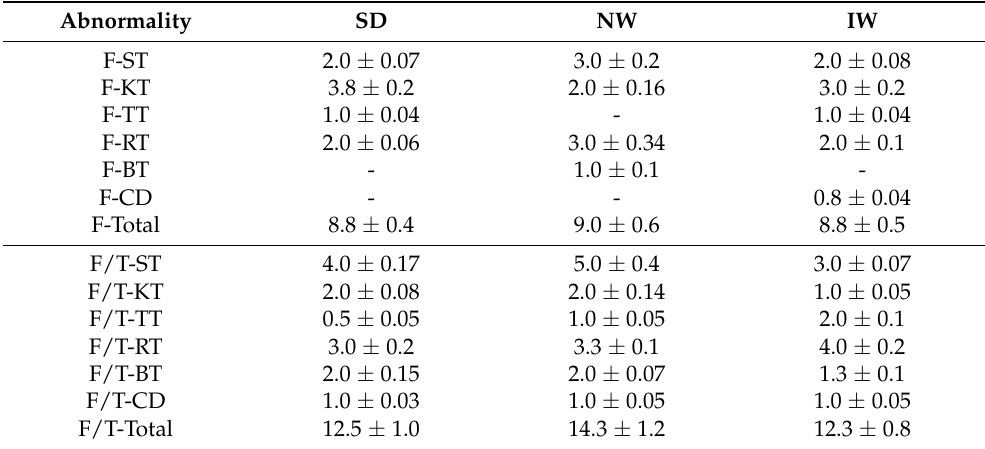
Table 1. Values of total and individual morphological abnormalities in fresh and F/T sperm for each examined breed